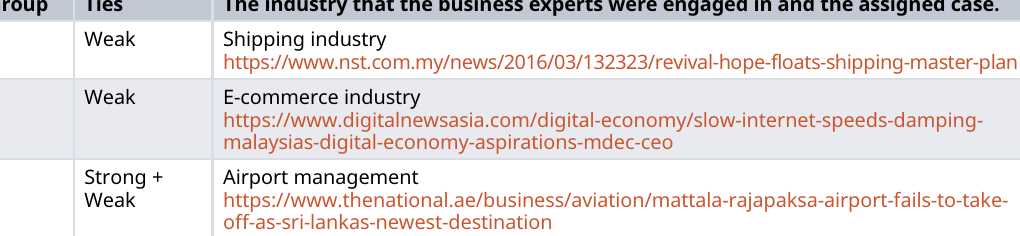
Table 1. The business experts ’ profile. Group Ties The industry that the business experts were engaged in and the assigned